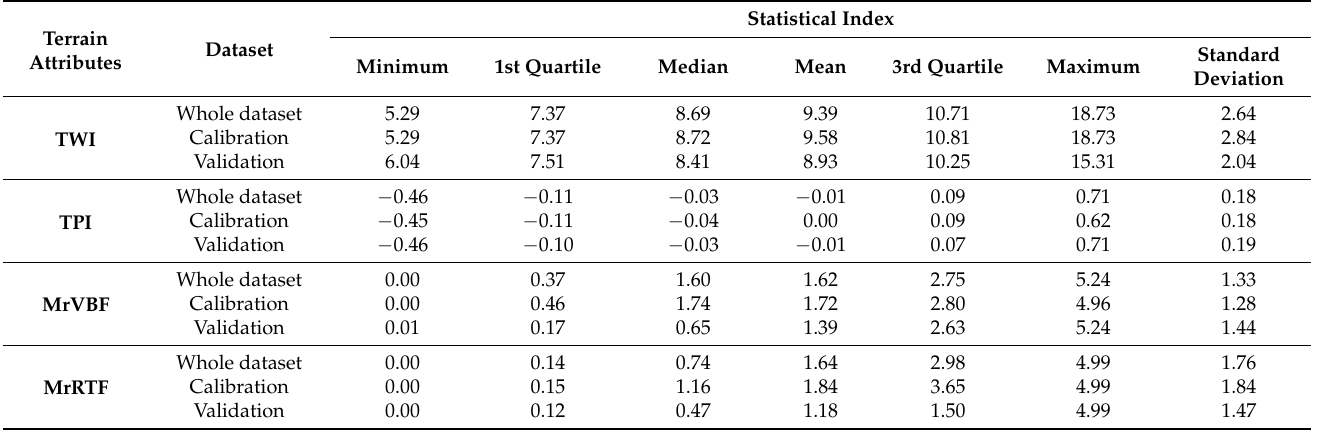
Table 3. Summary statistics of terrain attributes for the study